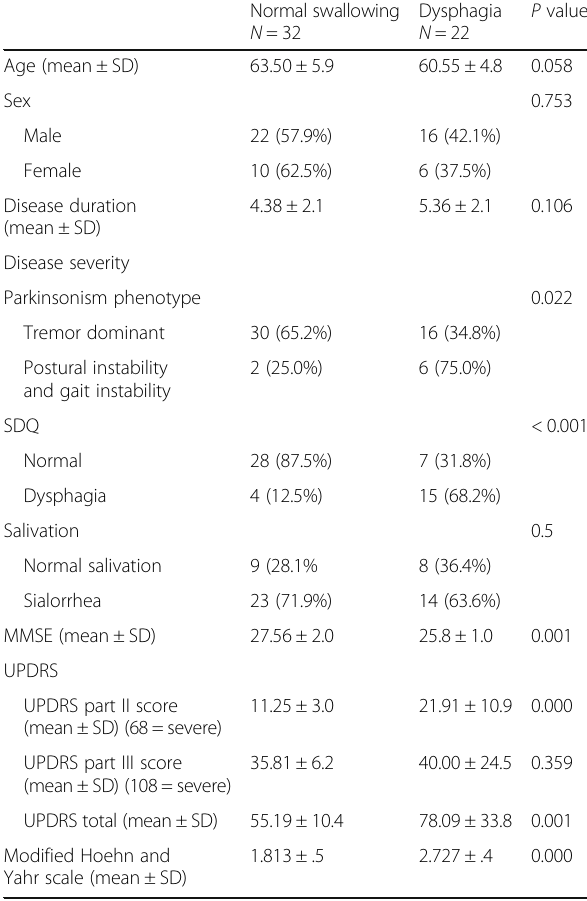
Table 2 Comparison of the baseline characteristics between subjects with and without dysphagia based on FEES